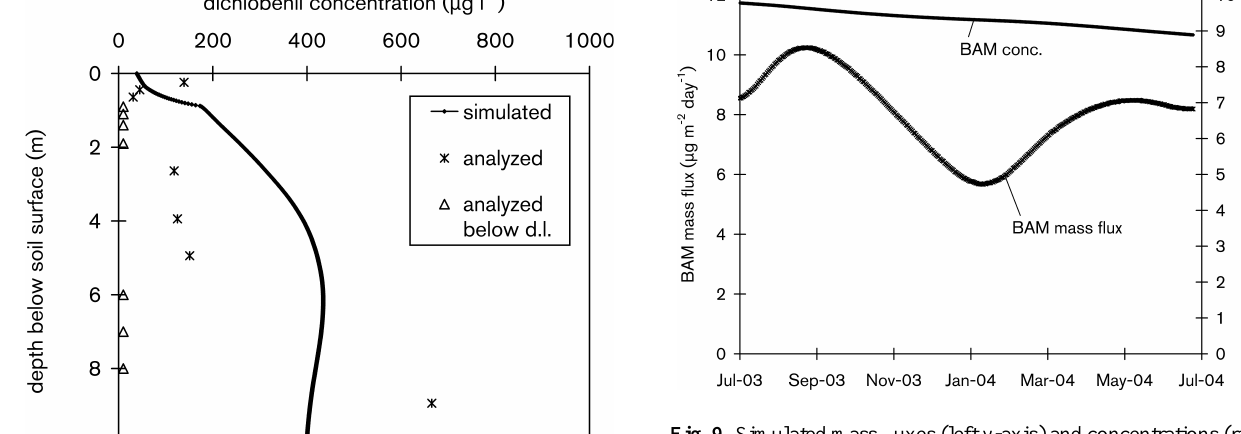
Fig. 9. Simulated mass fluxes (left y-axis) and concentrations (right y-axis) of BAM at the bottom of the 10.2m deep vadose zone model. The daily outflows and concentrations of BAM were gener- ated by the vadose zone model from 1 July 2003 to 30 June 2004. The assumed application rate of dichlobenil was 0.17gm − 2 , which was ten times lower than the rate in the calibrated model. The BAM concentrations from the vadose zone model were used as input to the groundwater